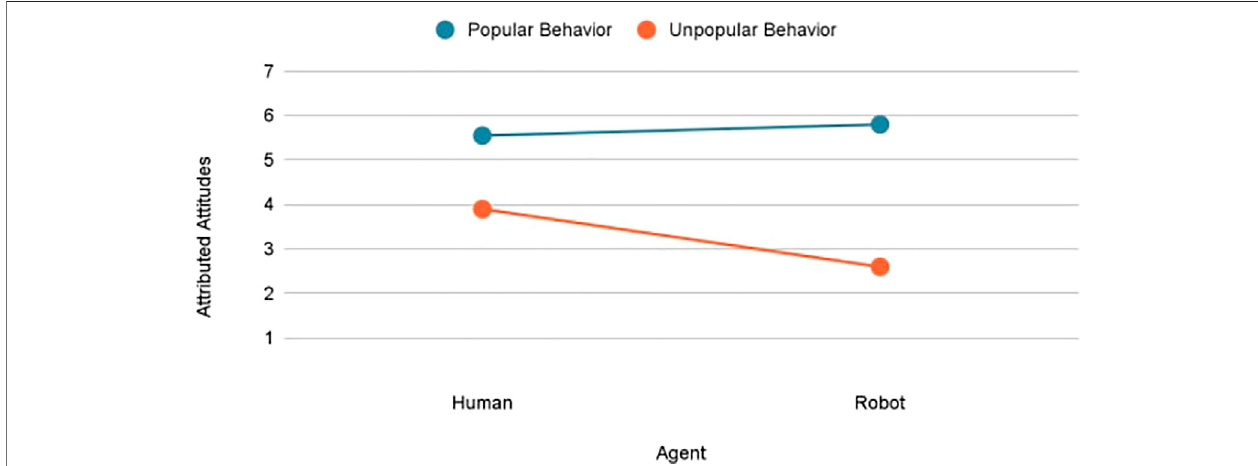
FIGURE 1 | Interaction effect of agent and behavior on attributed attitudes.